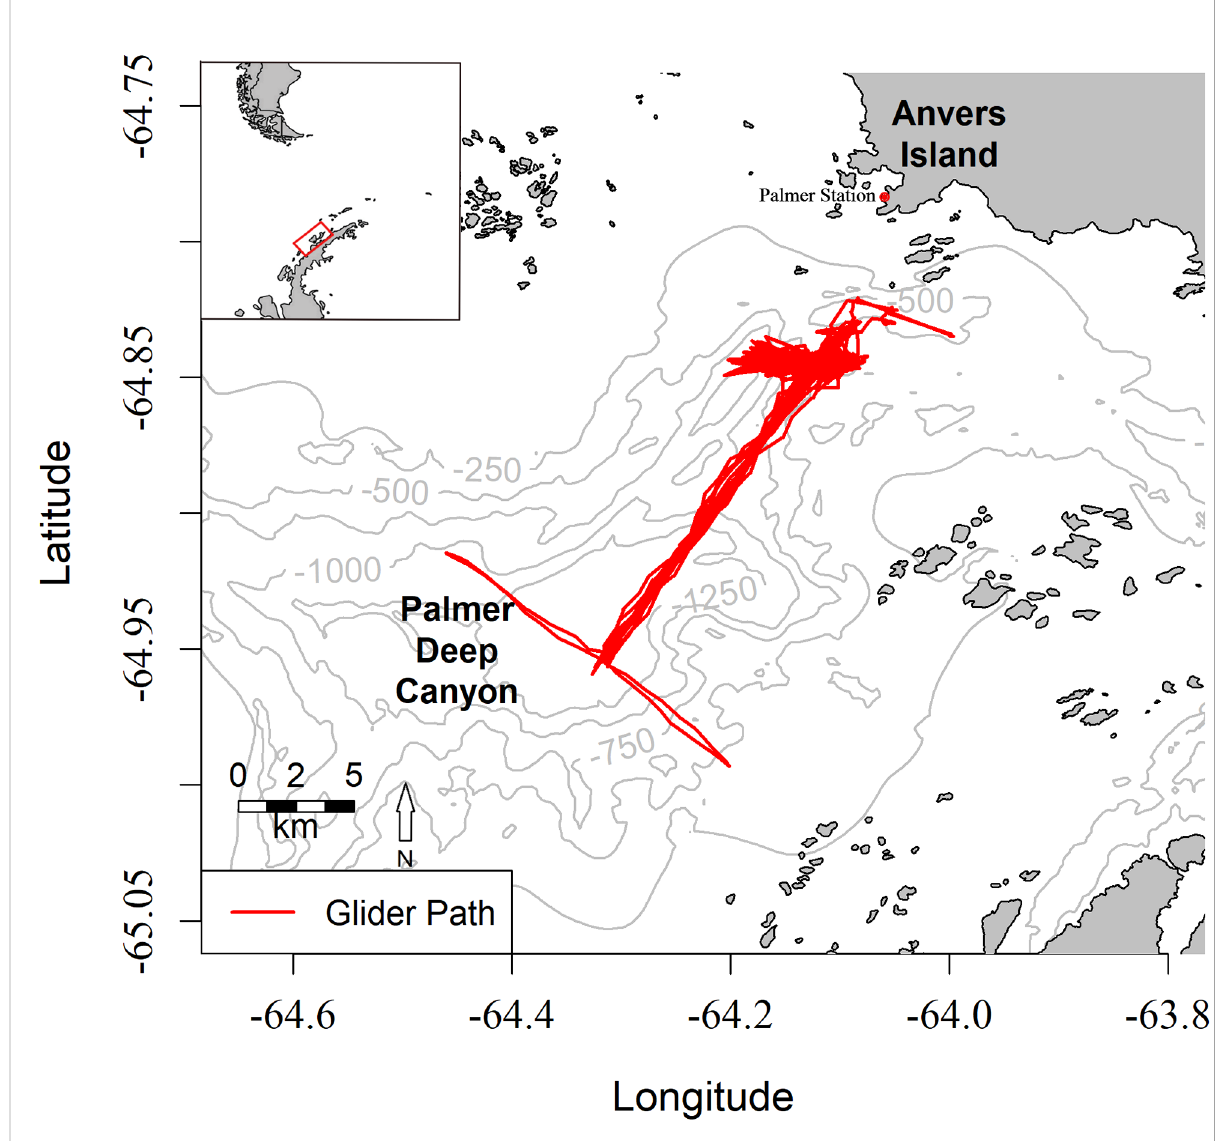
FIGURE 1 Map of survey area at Palmer Deep Canyon with tracks of the Slocum glider in red. Palmer Station on Anvers Island is marked with a red dot. Grey isoclines depict canyon bathymetry. The Western Antarctic Peninsula is visible in the inset with the red box illustrating the location of the survey